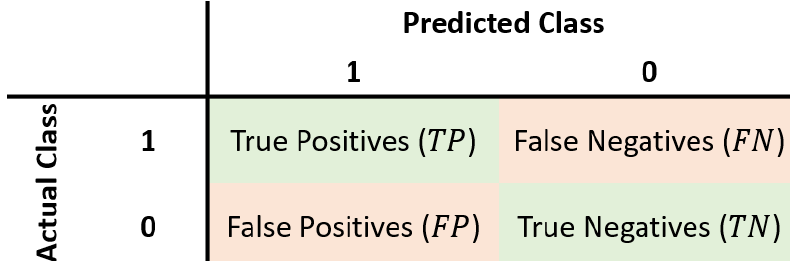
Figure 5. Confusion Matrix of a Binary Classifier.